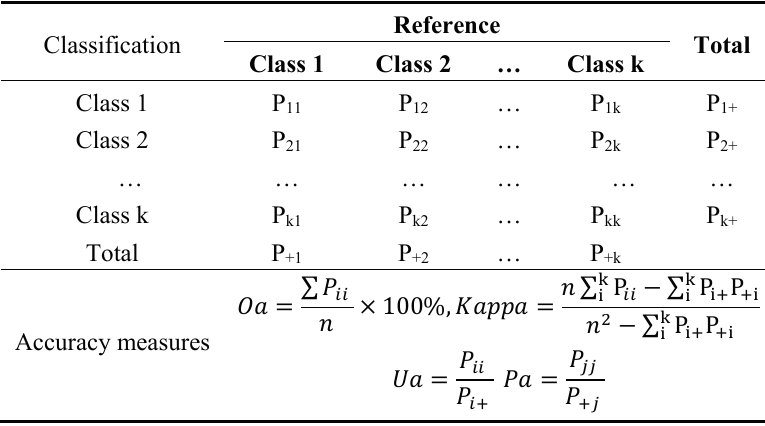
Table 3. Error matrix for soft